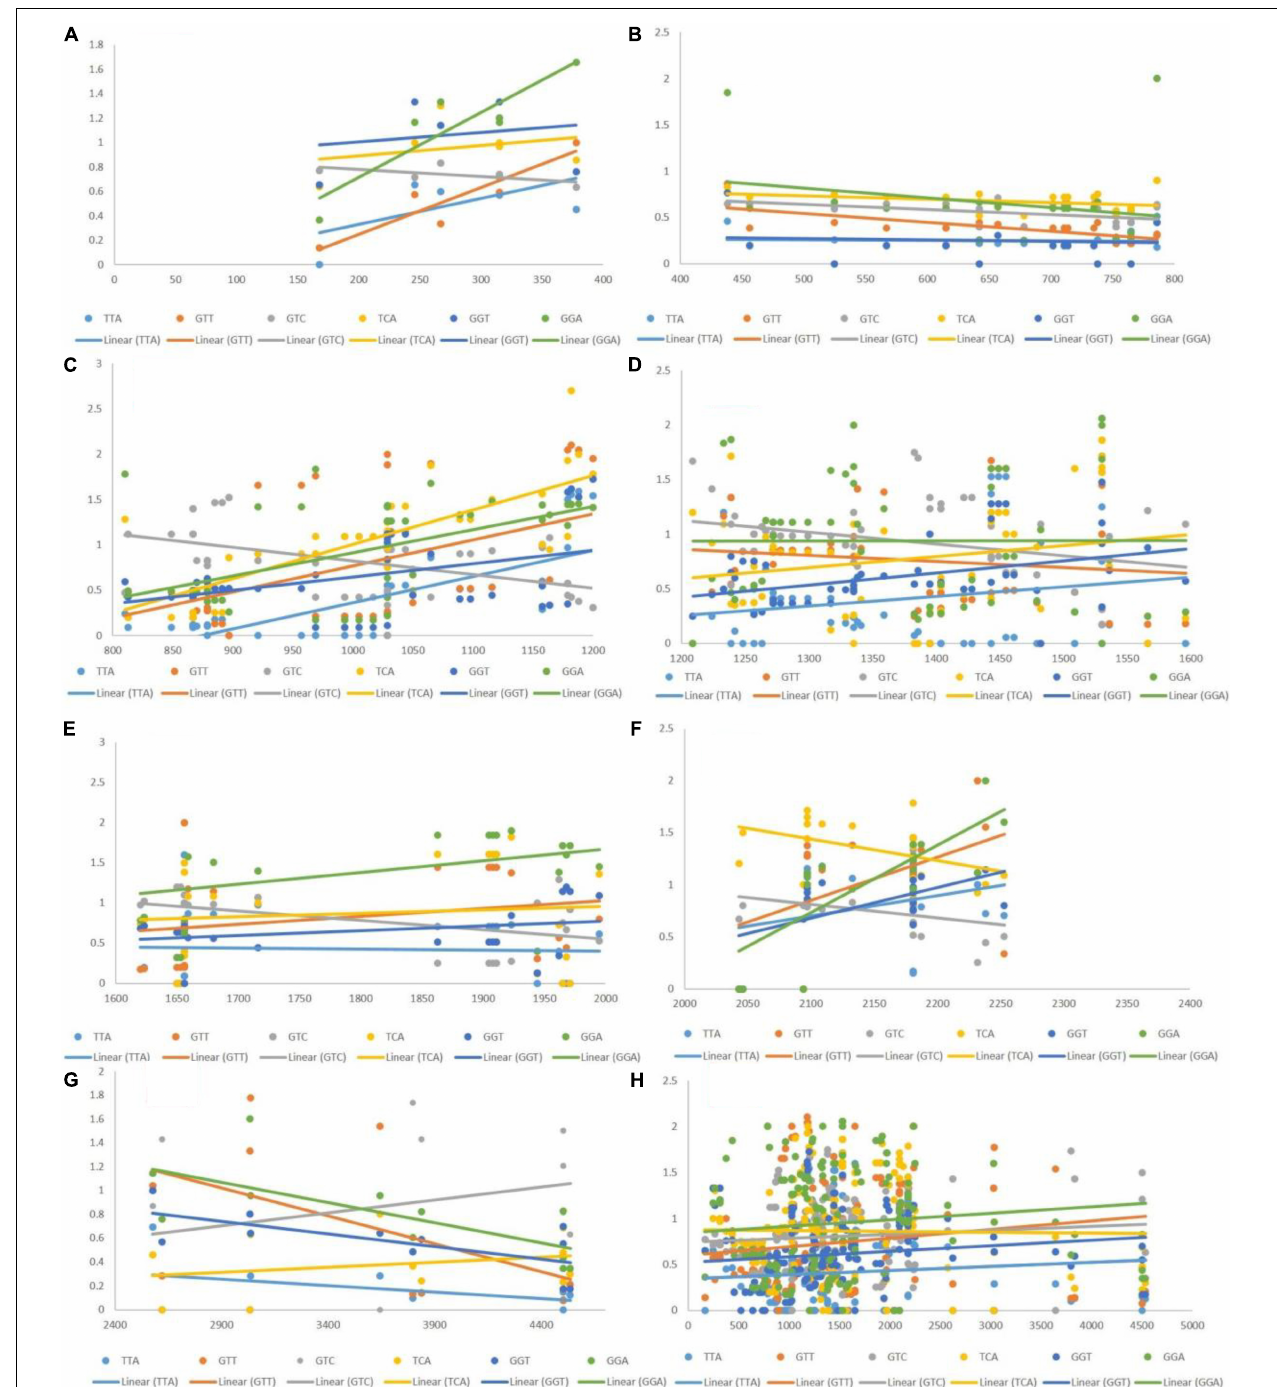
FIGURE 5 | Regression analysis of RSCU values of codons (negatively associated with gene length) with gene segments of various lengths. Each dot represents a codon, the trend line is depicted as a solid line, and color coding for each codon and trend line is given inside the figure. (A) 1–400 bp; (B) 400–800 bp; (C) 800–1,200 bp; (D) 1,200–1,600 bp; (E) 1,600–2,000 bp; (F) 2,000–2,400 bp; (G) 2,400–4,500 bp; (H) 1–4,500 bp.